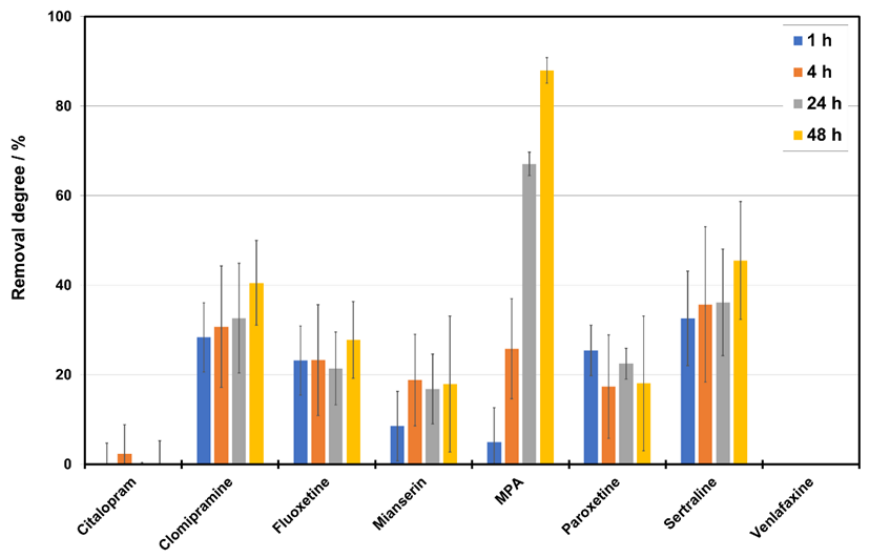
Figure 7. Removal degree by P. ostreatus of selected pharmaceuticals from a medium with CSL in the function of time.